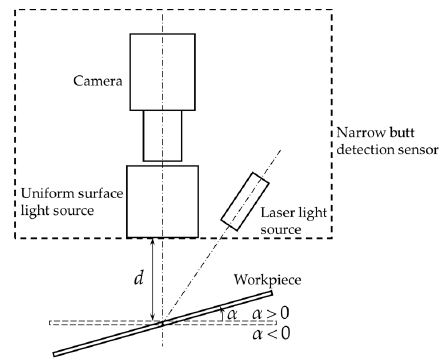
Figure 18. Relative positional relationship between the sensor and the workpiece.